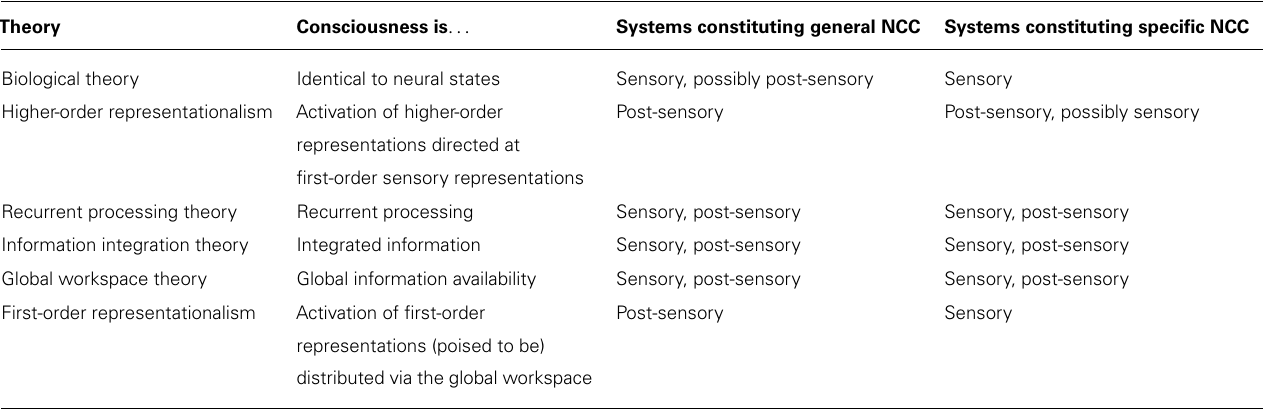
NCC, neural correlates of